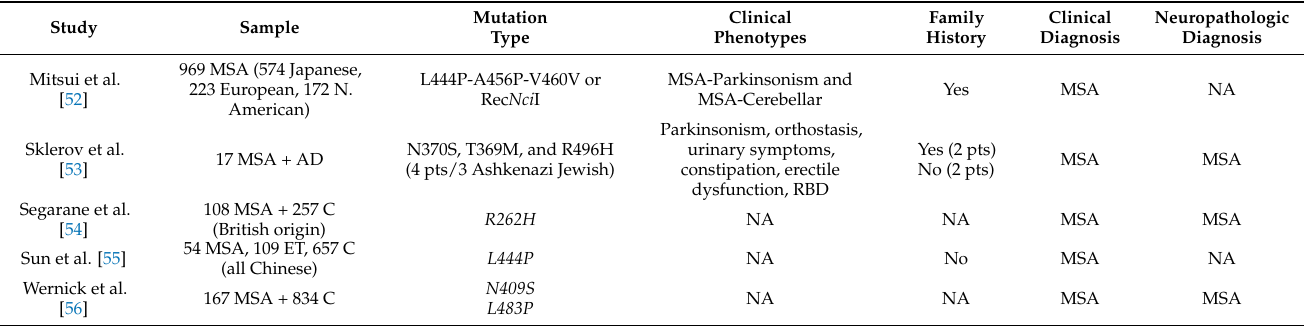
Table 2. GBA variants causing